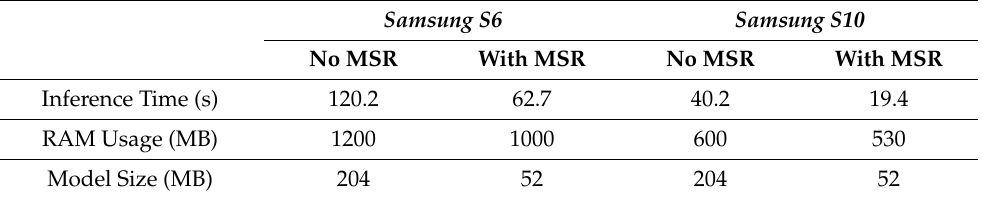
Table 8. Impact of model size reduction (MSR) on the SSD ResNet50 model deployed on mobile devices.